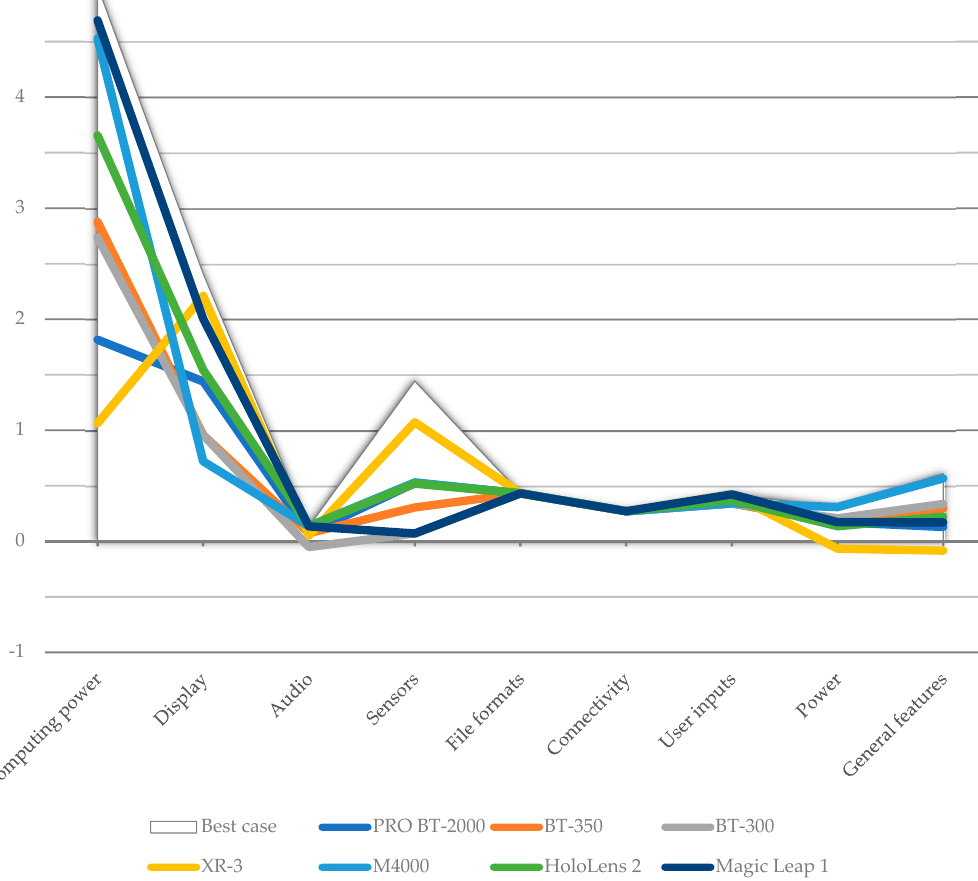
Figure 7 . Device evaluation chart for maxillofacial trauma surgery. Figure 7. Device evaluation chart for maxillofacial trauma